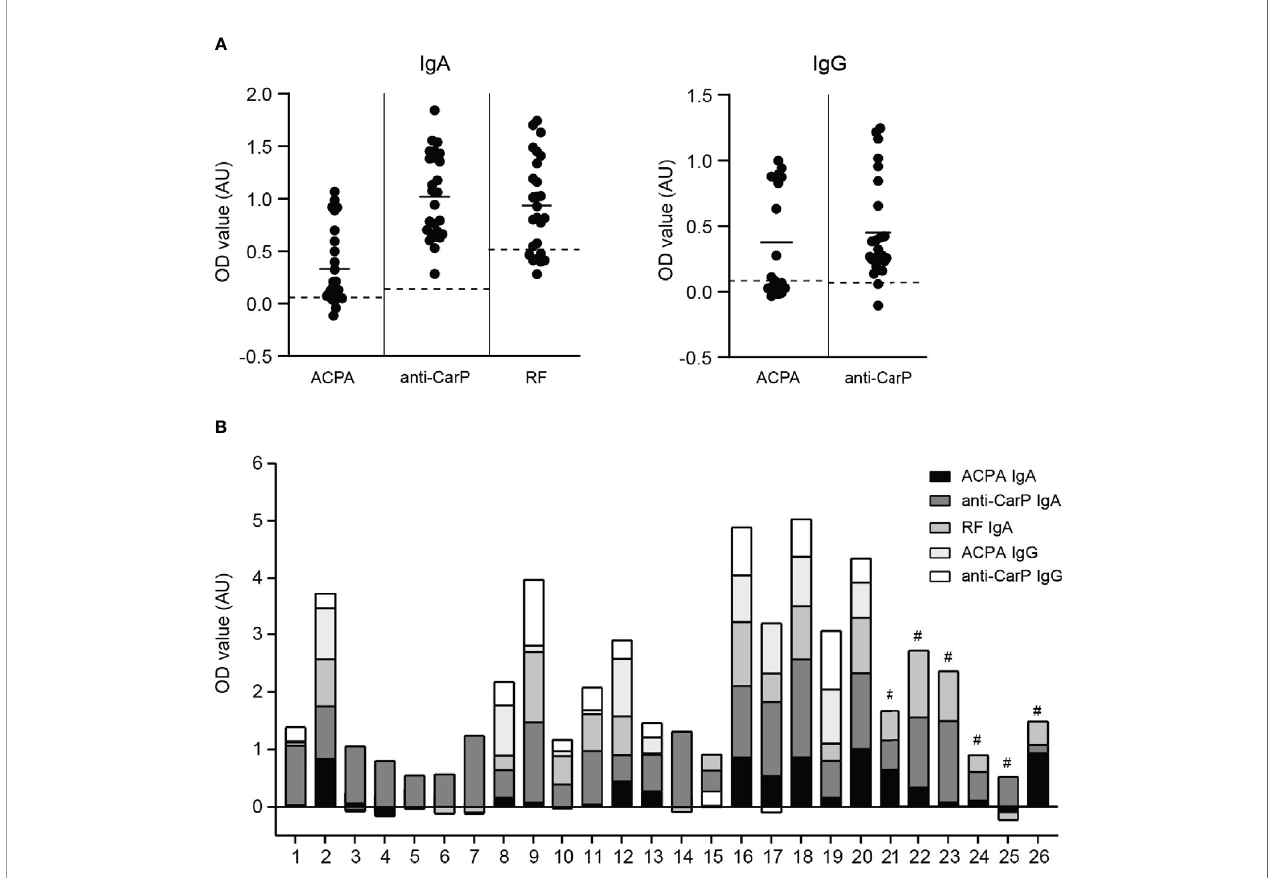
FIGURE 1 | IgA and IgG autoantibody levels in synovial fl uid of RA patients (A) left panel; ACPA, anti-CarP and RF IgA levels and right panel; ACPA and anti-CarP IgG levels in synovial fl uid of RA patients (expressed as OD value). Dotted lines represent blanc OD values of each independent ELISA. (B) Synovial fl uid pro fi le of ACPA, anti-CarP and RF IgA and IgG levels of 26 RA patients [# IgG levels not determined]. AU, arbitrary